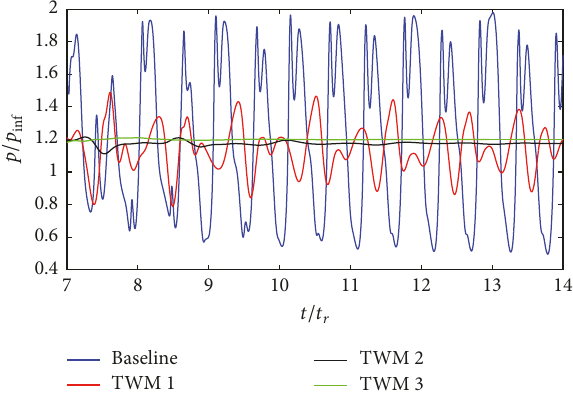
Figure 17: Pressure distribution at the control point with trailing edge wall